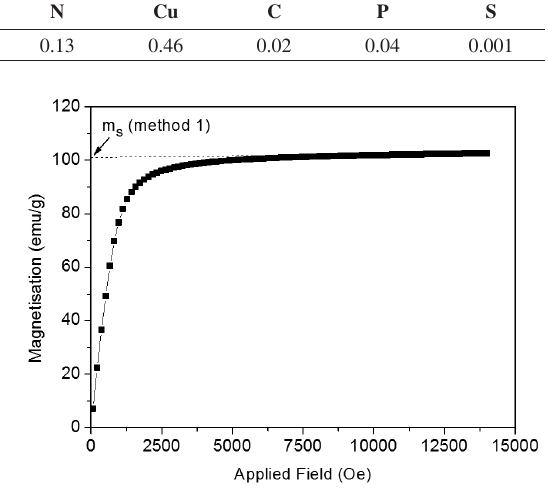
Figure 1. Magnetization curve of specimen LD